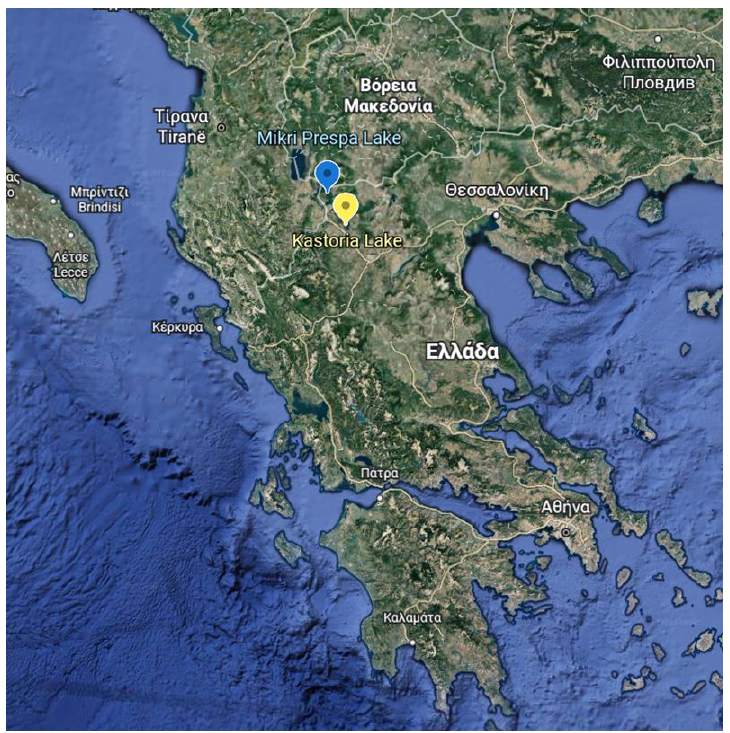
Figure 1. Geographical sites of Mikri Prespa and Kastoria lakes (maps by Google